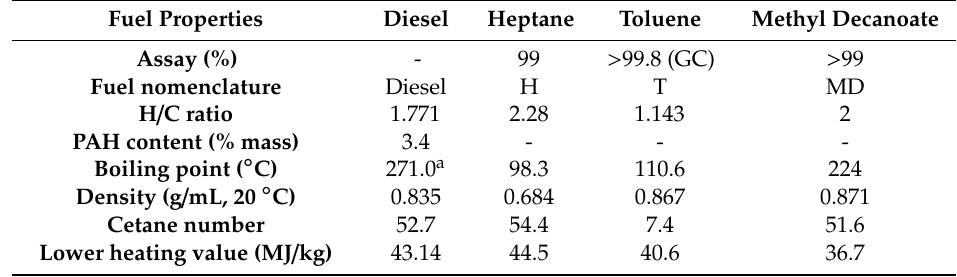
Table 2. Properties of test fuels. Point of 50% (v / v) recovery obtained according ASTM D86 [32–34]. Fuel